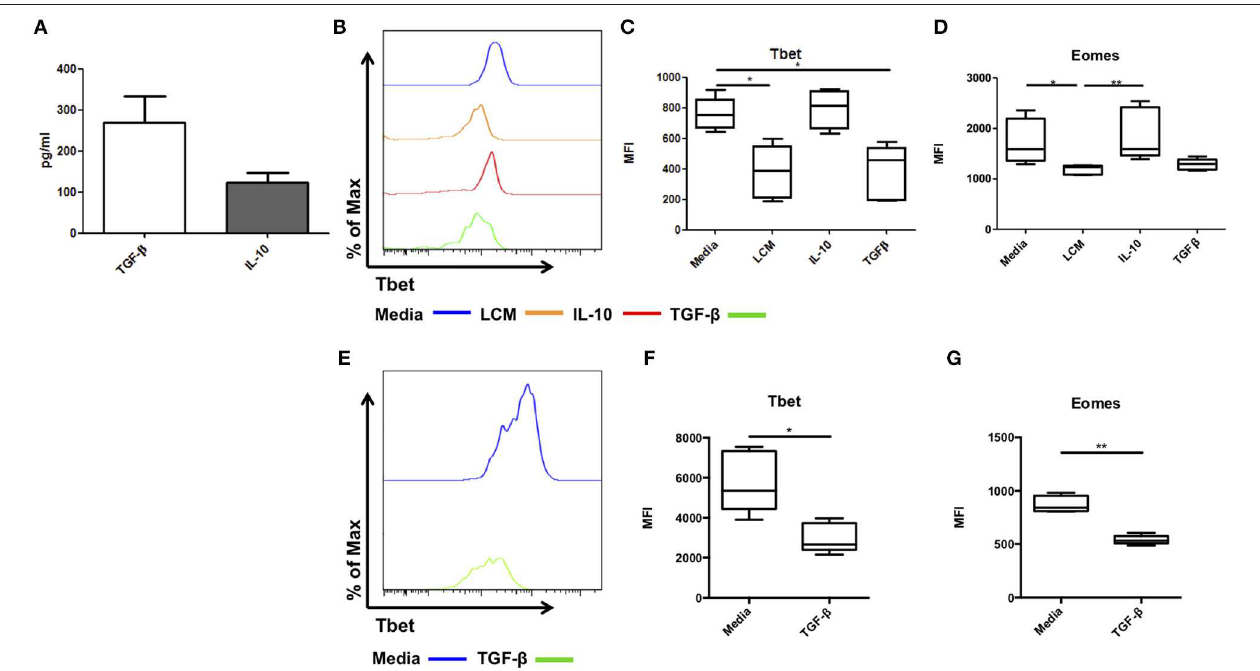
FIGURE 5 | TGF- β can regulate Tbet expression in liver resident and blood NK cells. Liver conditioned media (LCM) was generated from healthy donor liver biopsies. ELISA was performed for the cytokines TGF- β and IL-10. (A) Concentration of cytokines TGF- β and IL-10 from matched LCM samples ( n = 10). CD56 bright Eomes hi Tbet lo NK cells FACS isolated from liver perfusate (LP) were cultured for 7 days, supplemented with 10% v/v liver conditioned media (LCM), IL-10 (10ng/ml) or TGF- β (5ng/ml) and acquired on a FACS Fortessa. (B) Representative histogram of Tbet expression from cells at day 7 untreated (blue line), 10% LCM (orange line), IL-10 (red line), and TGF- β (green line). (C) MFI of Tbet in CD56 bright NK cells from LP at day 7 with LCM, IL-10 or TGF- β treatments. (D) MFI of Eomes in CD56 bright NK cells from LP at day 7 with LCM, IL-10 or TGF- β treatments. (E) Representative histogram of Tbet expression from blood NK cells at day 7 untreated (blue line) or TGF- β (green line). (F) MFI of Tbet in PB CD56 bright NK cells at day 7 with or without TGF- β . (G) MFI of Eomes in PB CD56 bright NK cells at day 7 with or without TGF- β . Data presented as mean ± SEM (A) or box and whisker plots with minimum and maximum values (C,D,F,G) . Data was analyzed using Friedman test, with Dunn’s multiple comparison test or paired t -test ( n = 5; * p < 0.05 and ** p <